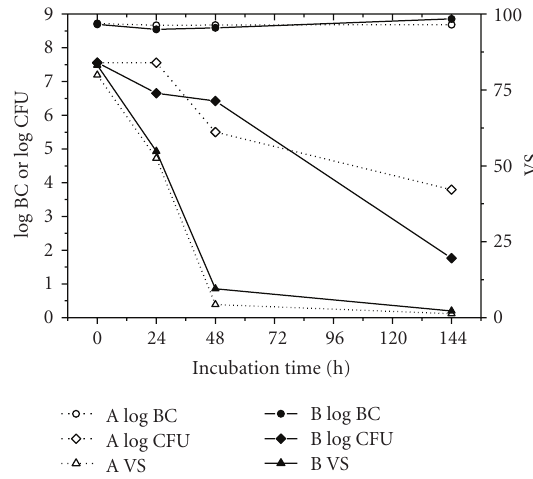
Figure 6: Microbiological parameters of S. mutans cultures in medium A without sucrose (open symbols) and medium B with 5% sucrose (filled symbols): ◦ / • log BC, ♦ / (cid:4) log CFU, (cid:2) / (cid:3) vitality (VS) at 24 h, 48h, and 144 h incubation